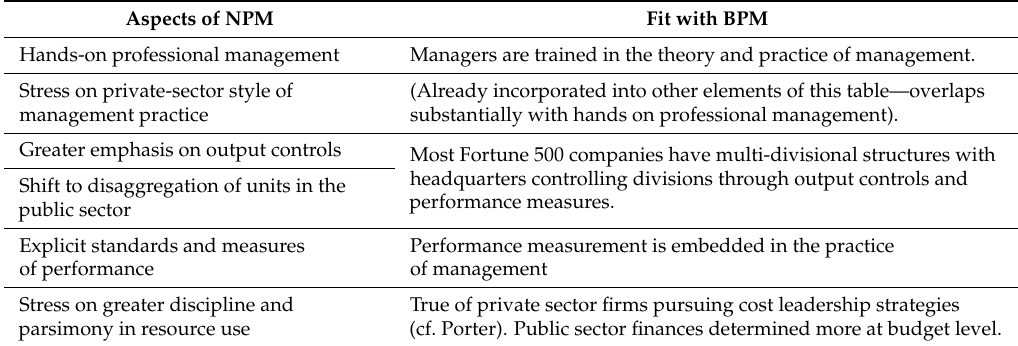
Table 1. New Public Management compared with Business Policy